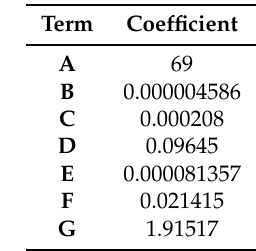
Table 6. NOx polynomial coefficients.